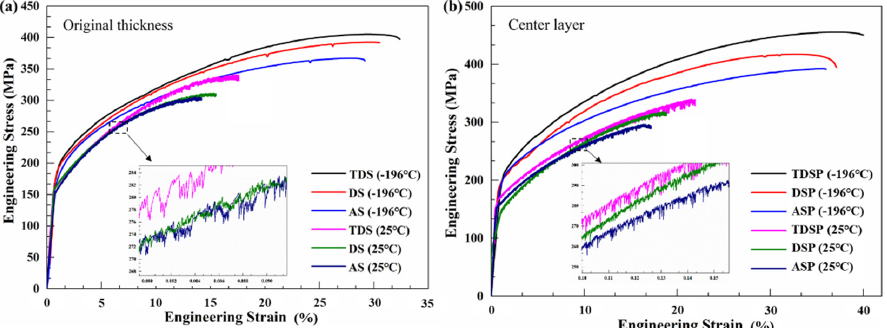
Figure 4. Engineering stress versus strain curves of the Ot and Cl samples of three different plates at different temperatures: ( a ) 25 °C; ( b ) − 196 °C. Table 2. Tensile properties test results of the Ot and Cl samples of the three different plates at different temperatures.